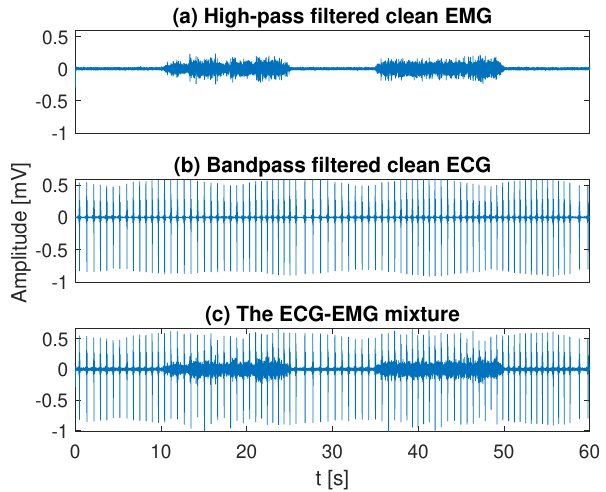
Figure 2. An example of the EMG ( a ), ECG ( b ), and their mixture ( c